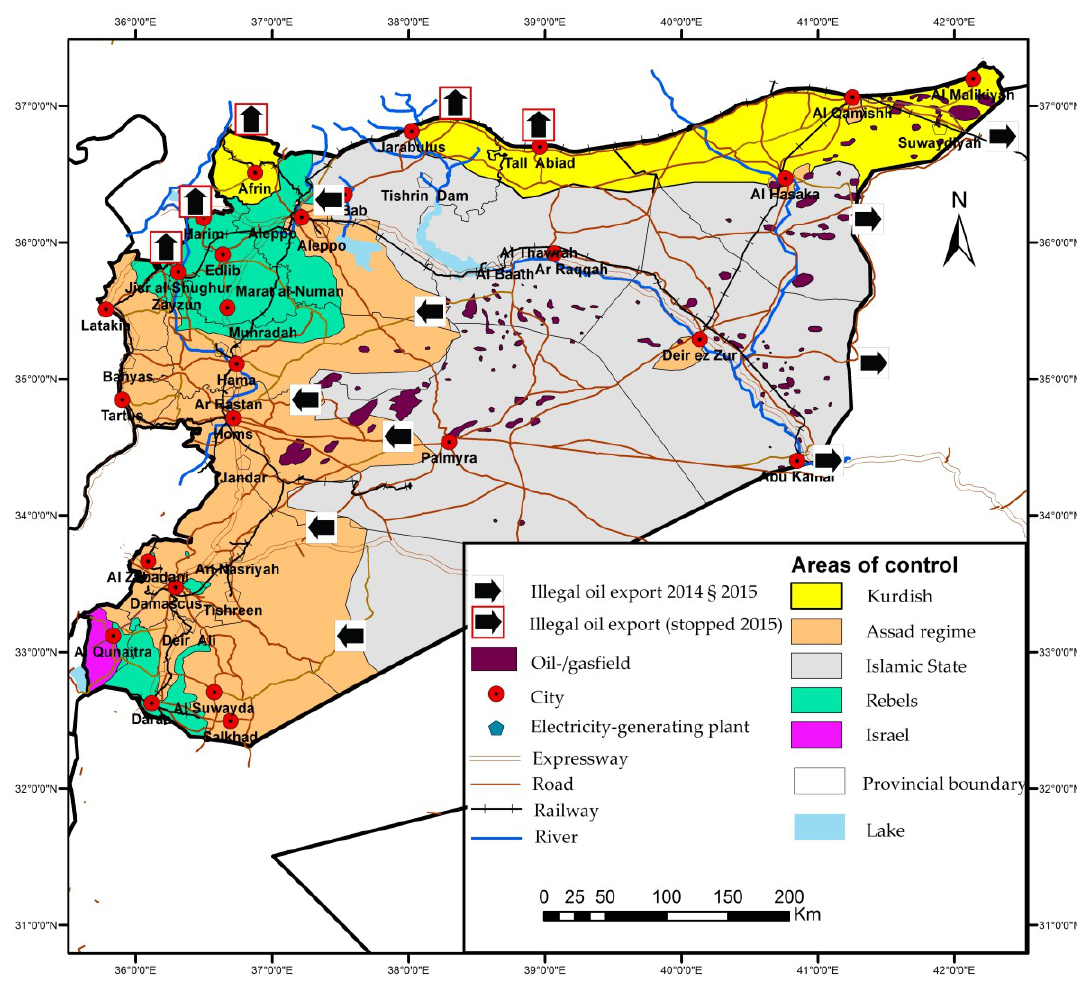
Figure 6. Geographical distribution of the control of Syrian oil and gas fields by forces and illegal export.